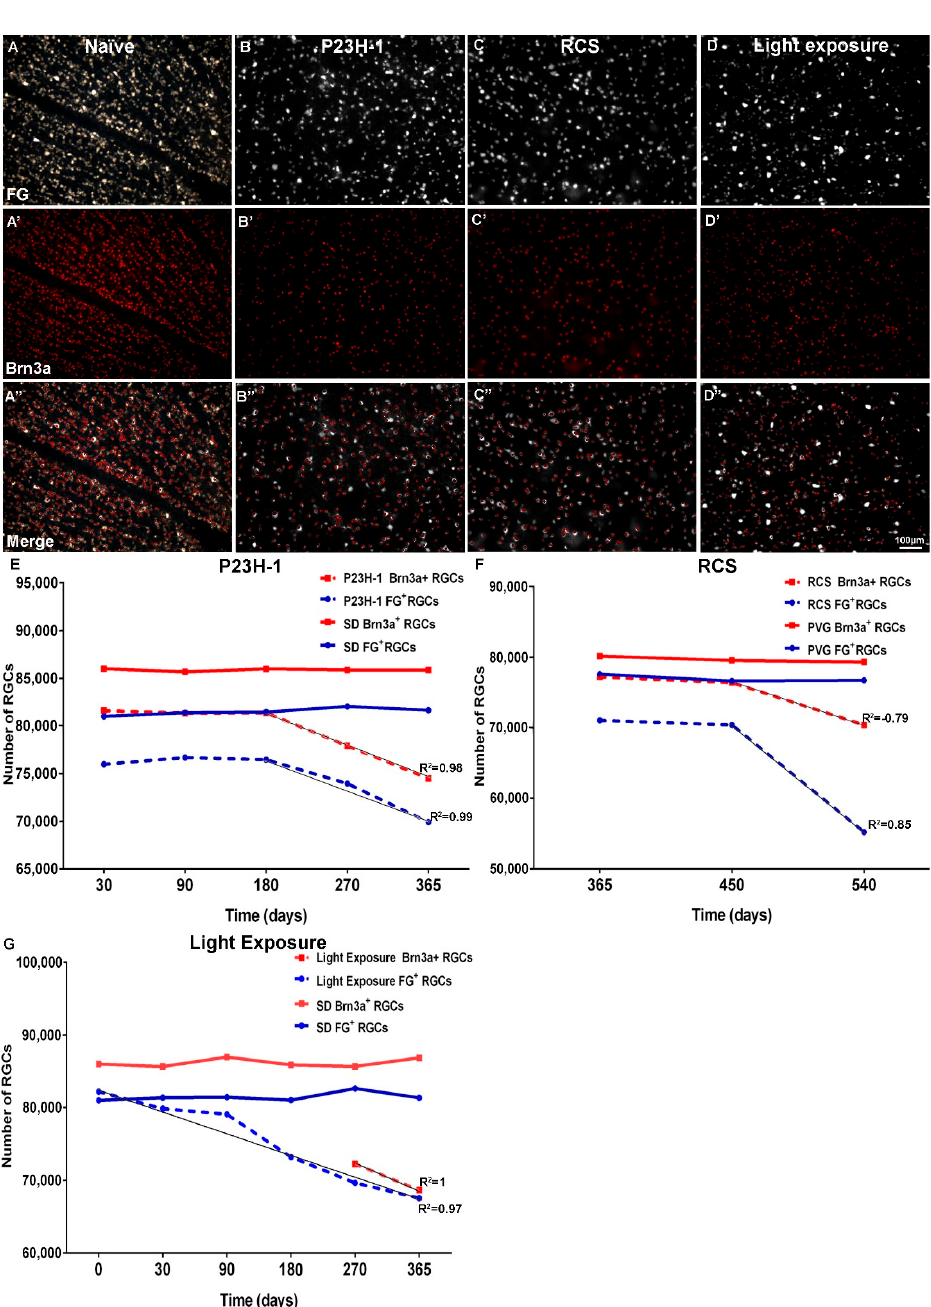
Figure 5. RGC loss following photoreceptor degeneration. Microphotographs from a representative naïve SD rat retina and a P23H-1, RCS and light-exposed retina showing fluorogold (FG)+RGCs ( A , B , C , D ), Brn3a+RGCs ( A’ , B’ , C’ , D’ ), merged images ( A’’ , B’’ , C’’ , D’’ ), and X, Y graphs showing the evolution of the RGC populations (Y axis) with age or time (X axis) in naïve SD and P23H-1 rats ( E) , RCS and Pievald Viro Glaxo (PVG) rats ( F ) and in naïve SD and light-exposed SD rats ( G ). Data are from García-Ayuso et al. [9–11].